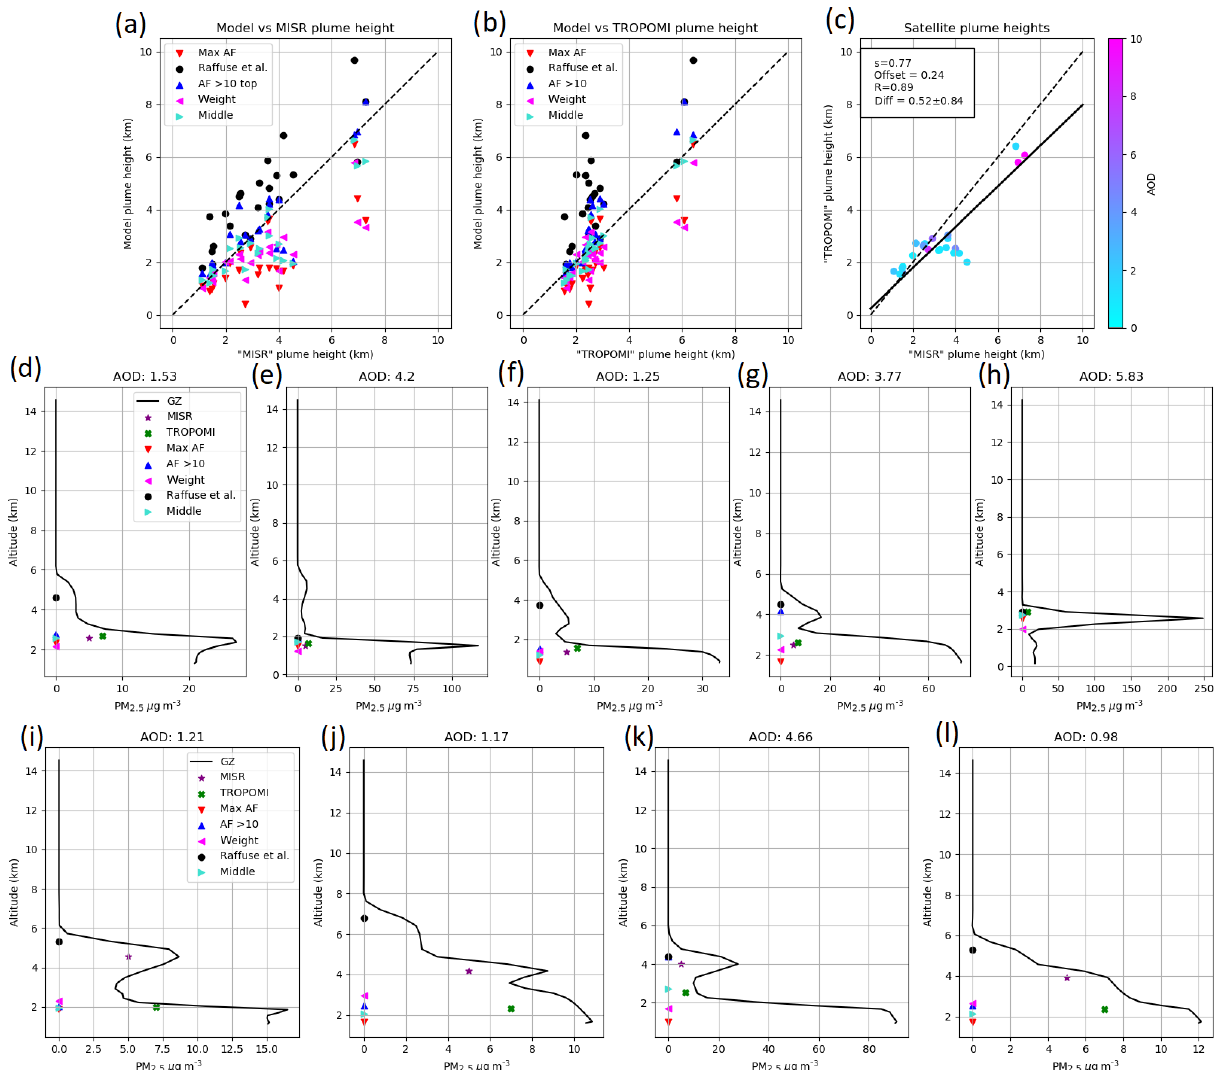
Figure 1. Observing system simulation experiments (OSSE) results for the simple methods (see text) versus (a) simulated MISR and (b) sim- ulated TROPOMI heights. Simulated MISR versus TROPOMI plume heights are shown in (c) , together with the statistics of the line of best fit (correlation coefficient R , slope s , and mean difference ± standard deviation in kilometres). Five example profiles in which simulated MISR and TROPOMI plume heights agree well are shown in (d) – (h) , and four example profile where there are significant differences are shown in (i) – (l) . The TROPOMI-OSSE and MISR-OSSE heights (d–l) are plotted with a PM 2 . 5 offset simply for